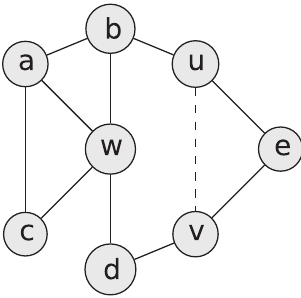
Fig 1. Example network to illustrate notation. G = ( V , E ) with n = 8 nodes, 10 links, V = { a , b , c , d , e , u , v , w }, and E = {( a , b ), ( a , w ), ( a , c ), ( b , u ), ( b , w ), ( u , e ), ( w , c ), ( w , d ), ( e , v ), ( d , v )}. We choose m = 1 link from the set E ¼ V � V n E of all links not included in G . G 0 is the network G after link ( u , v ) (represented as dashed line) was added: G 0 ≔ G + uv . Then N ( w ) = { a , b , c , d }, d ¼ d 0 ¼ 4 , T ( w ) = T 0 ( w ) = 2 (the triangles abw and acw ) and C ð w Þ ¼ 2 � 2 ¼ 1 . For u we w w 4 ð 4 (cid:0) 1 Þ 3 = 2 and d 0 ¼ 3 and similarly T ( u ) = 0 and T 0 ( u ) = 1 (the triangle uev ). N ( u , v ) = { e } and k = | N ( u , v )| = 1. The obtain d (cid:0) � u u clustering coefficient of G equals C ¼ 1 � 1 þ 0 þ 0 þ 1 þ 2 þ 1 þ 0 þ 0 ¼ 1 � 7 ¼ 7 and the clustering coefficient G 8 3 3 3 8 3 24